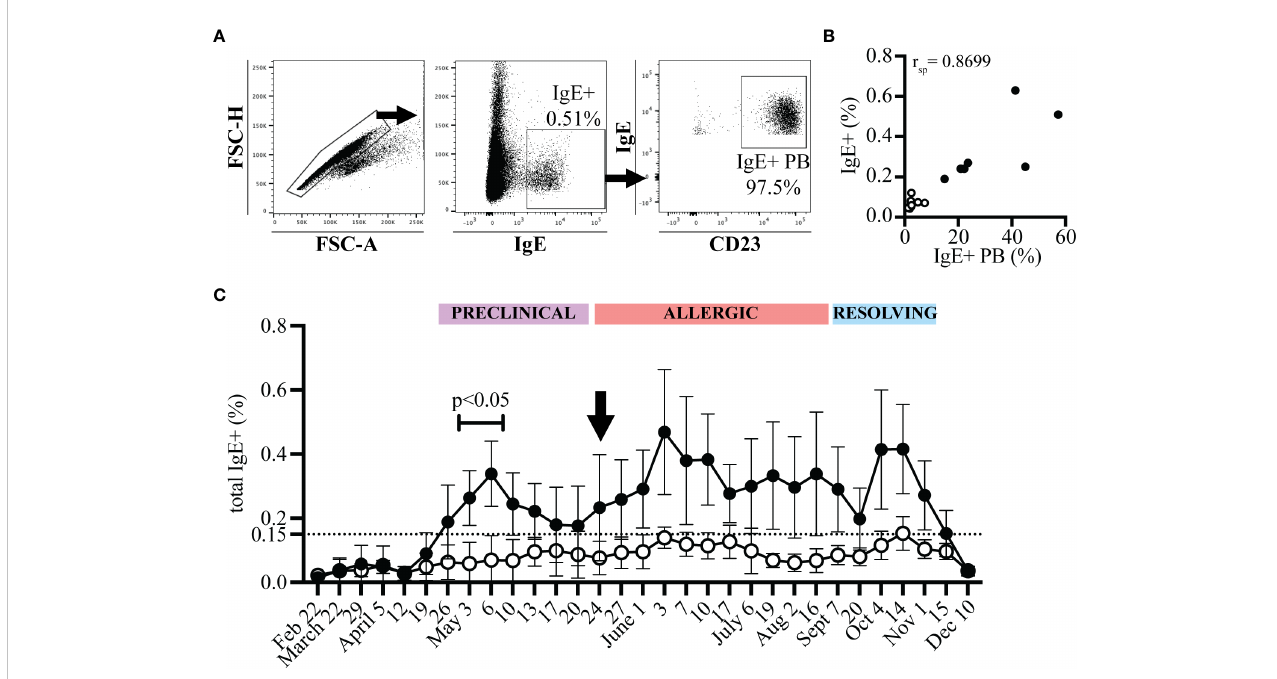
FIGURE 4 IgE+ plasmablasts are detectable in total PBL samples by acid wash followed by anti-IgE staining only. PBL were collected at each timepoint from allergic (n=7, black circles) and healthy (n=10, open circles) horses. PBL were acid washed and stained with an antibody against IgE. (A) Gating strategy to quantify IgE+ plasmablasts by only IgE expression. Doublets were excluded (left), IgE+ cells were selected (middle), and expression of CD23 by IgE+ cells was con fi rmed. (B) Spearman rank correlation of the frequency of IgE+ plasmablasts (IgE+ out of CD23+) and of total IgE+ cells (out of PBL) on July 19 from allergic (n=7, black circles) and healthy (n=10, open circles) horses. (C) The frequency of total IgE+ cells at each timepoint. The dotted line represents the threshold were allergic horses have ≥ 0.15% total IgE+ cells a few weeks prior to and during clinical allergy. Flow cytometry images are representative from 1 out of 17 horses. Graphs show mean and standard